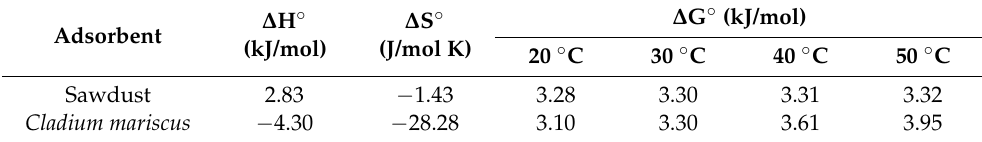
Table 6. Thermodynamic parameters of BB3 adsorption onto sawdust and Cladium mariscus saw- sedge.